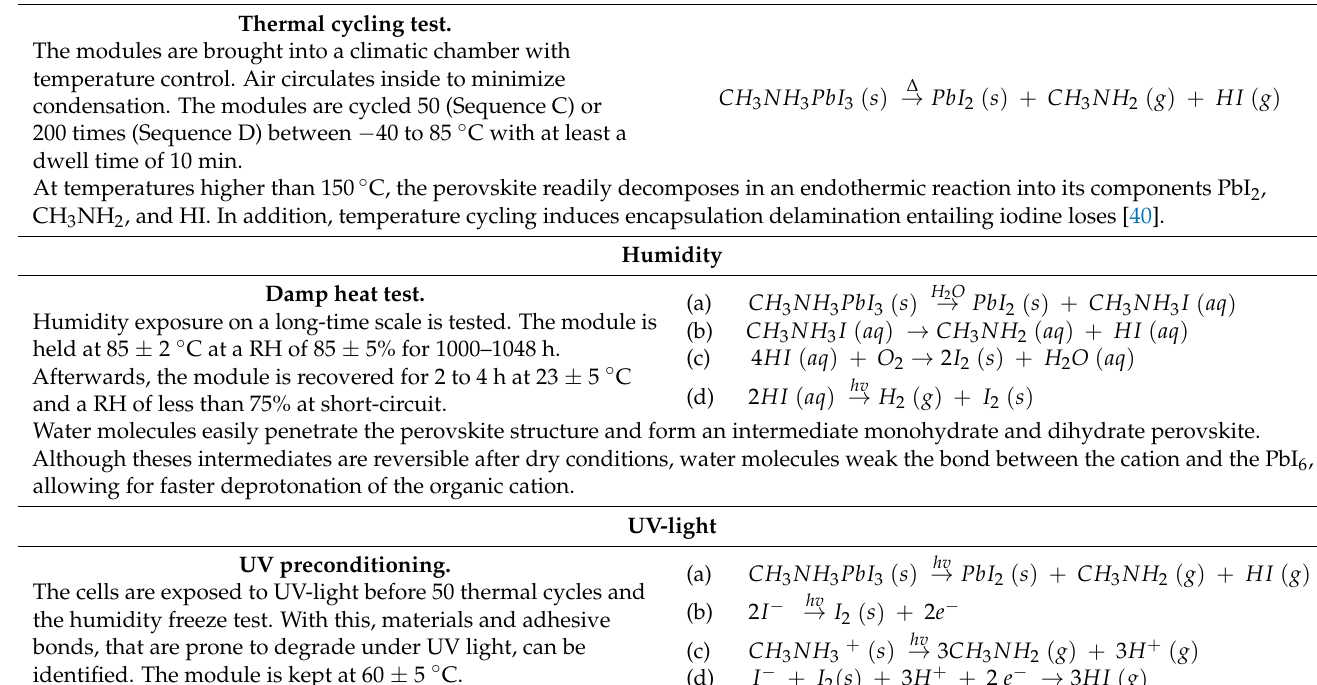
Table 2. Summary of the test performed at the IEC 61215:2016, the chemical reaction proposed depending on the external parameter [39]. Temperature Thermal cycling